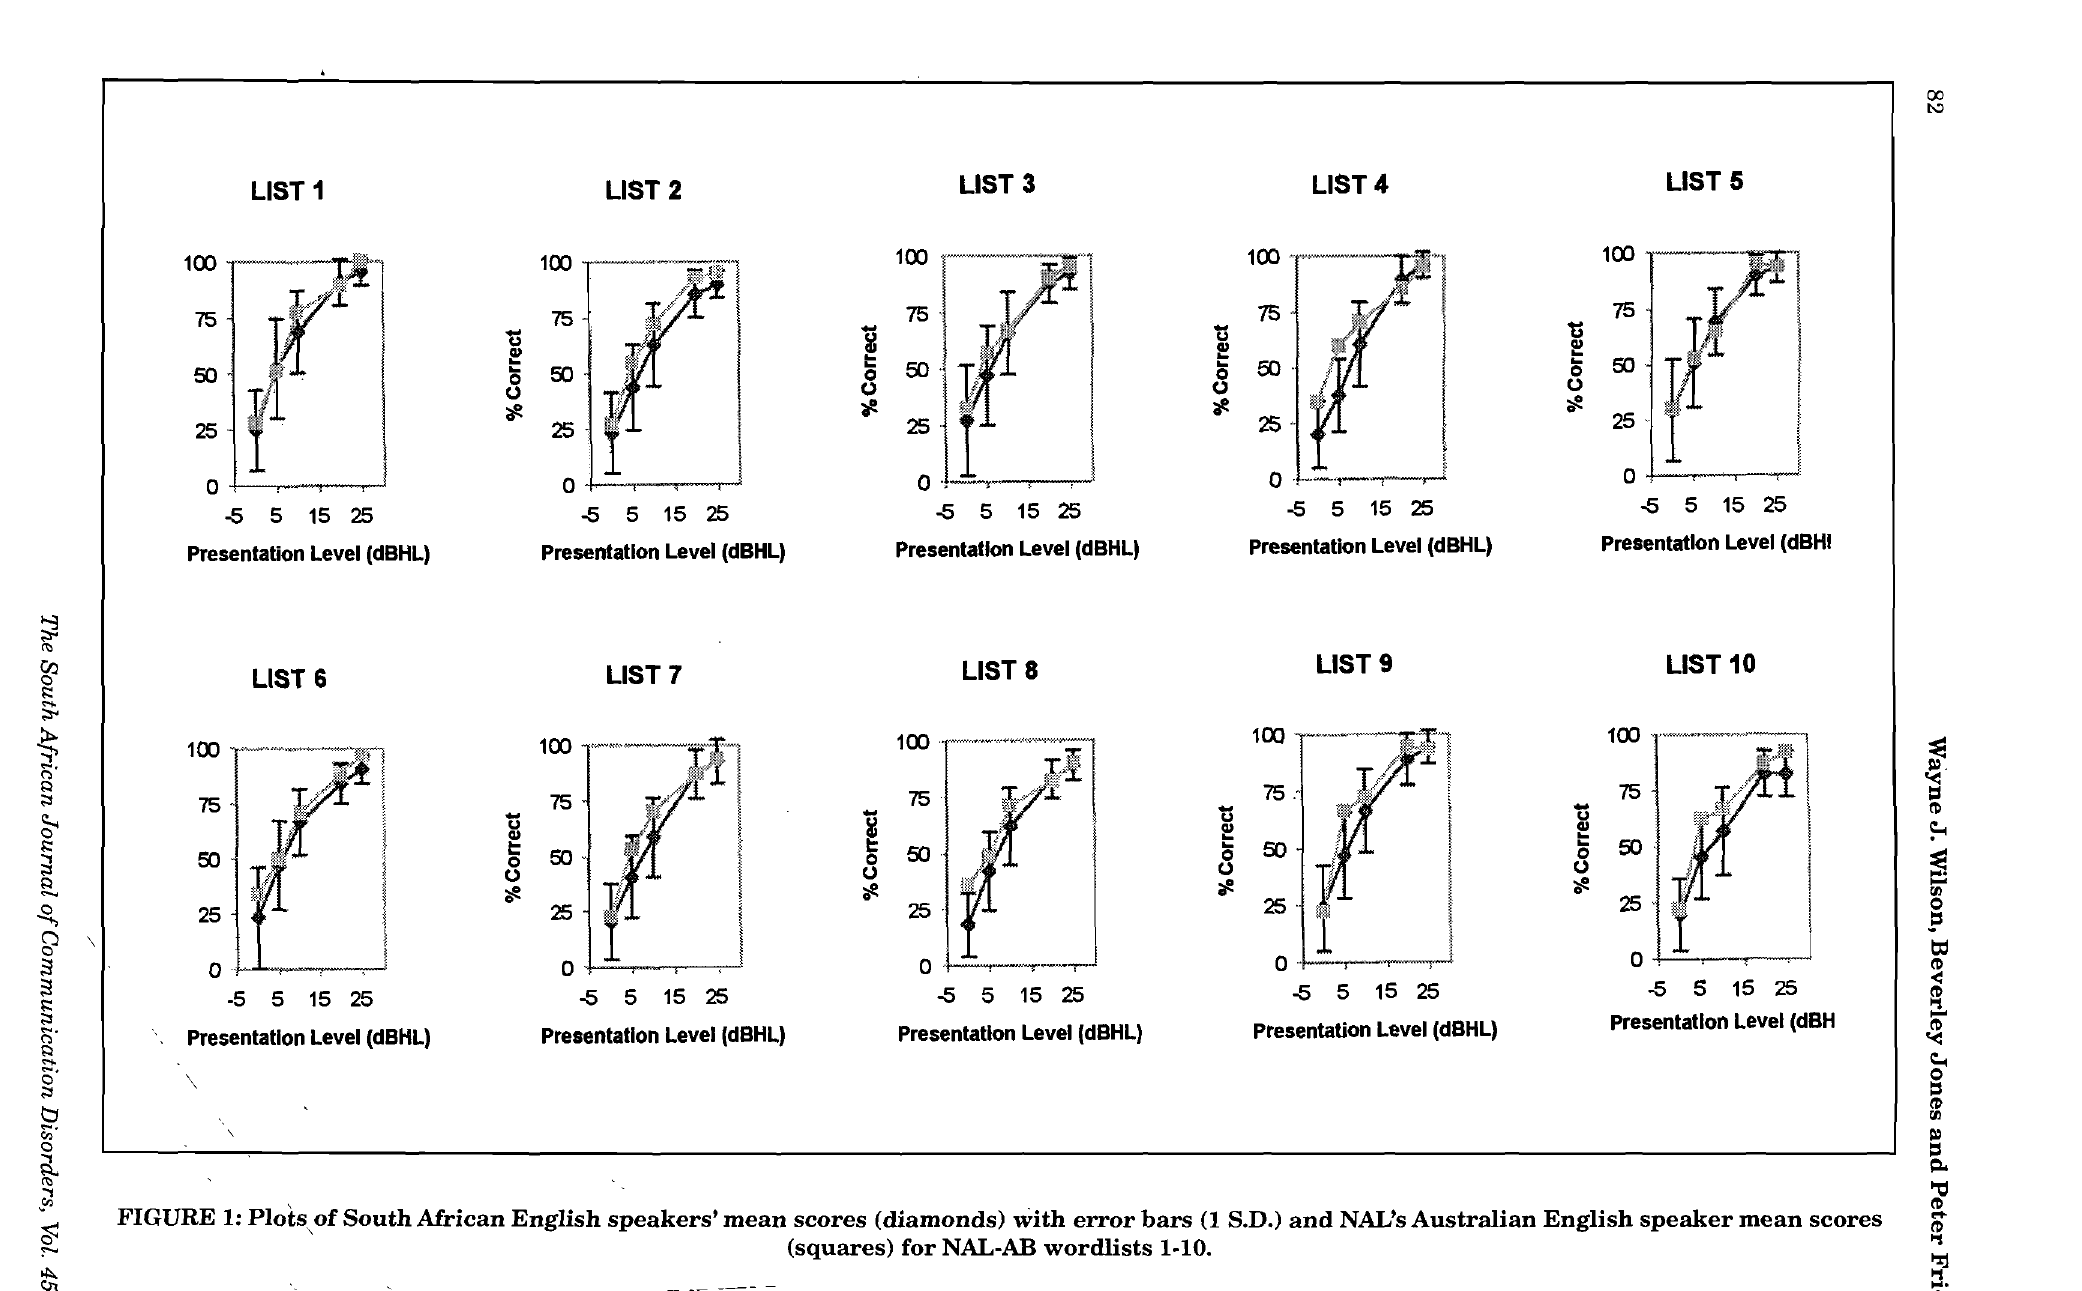
FIGURE 1: Plots, of South Mrican English speakers' mean scores (diamonds) with error bars (1 S.D.) and NAL's Australian English speaker mean scores (squares) for NAL-AB wordlists